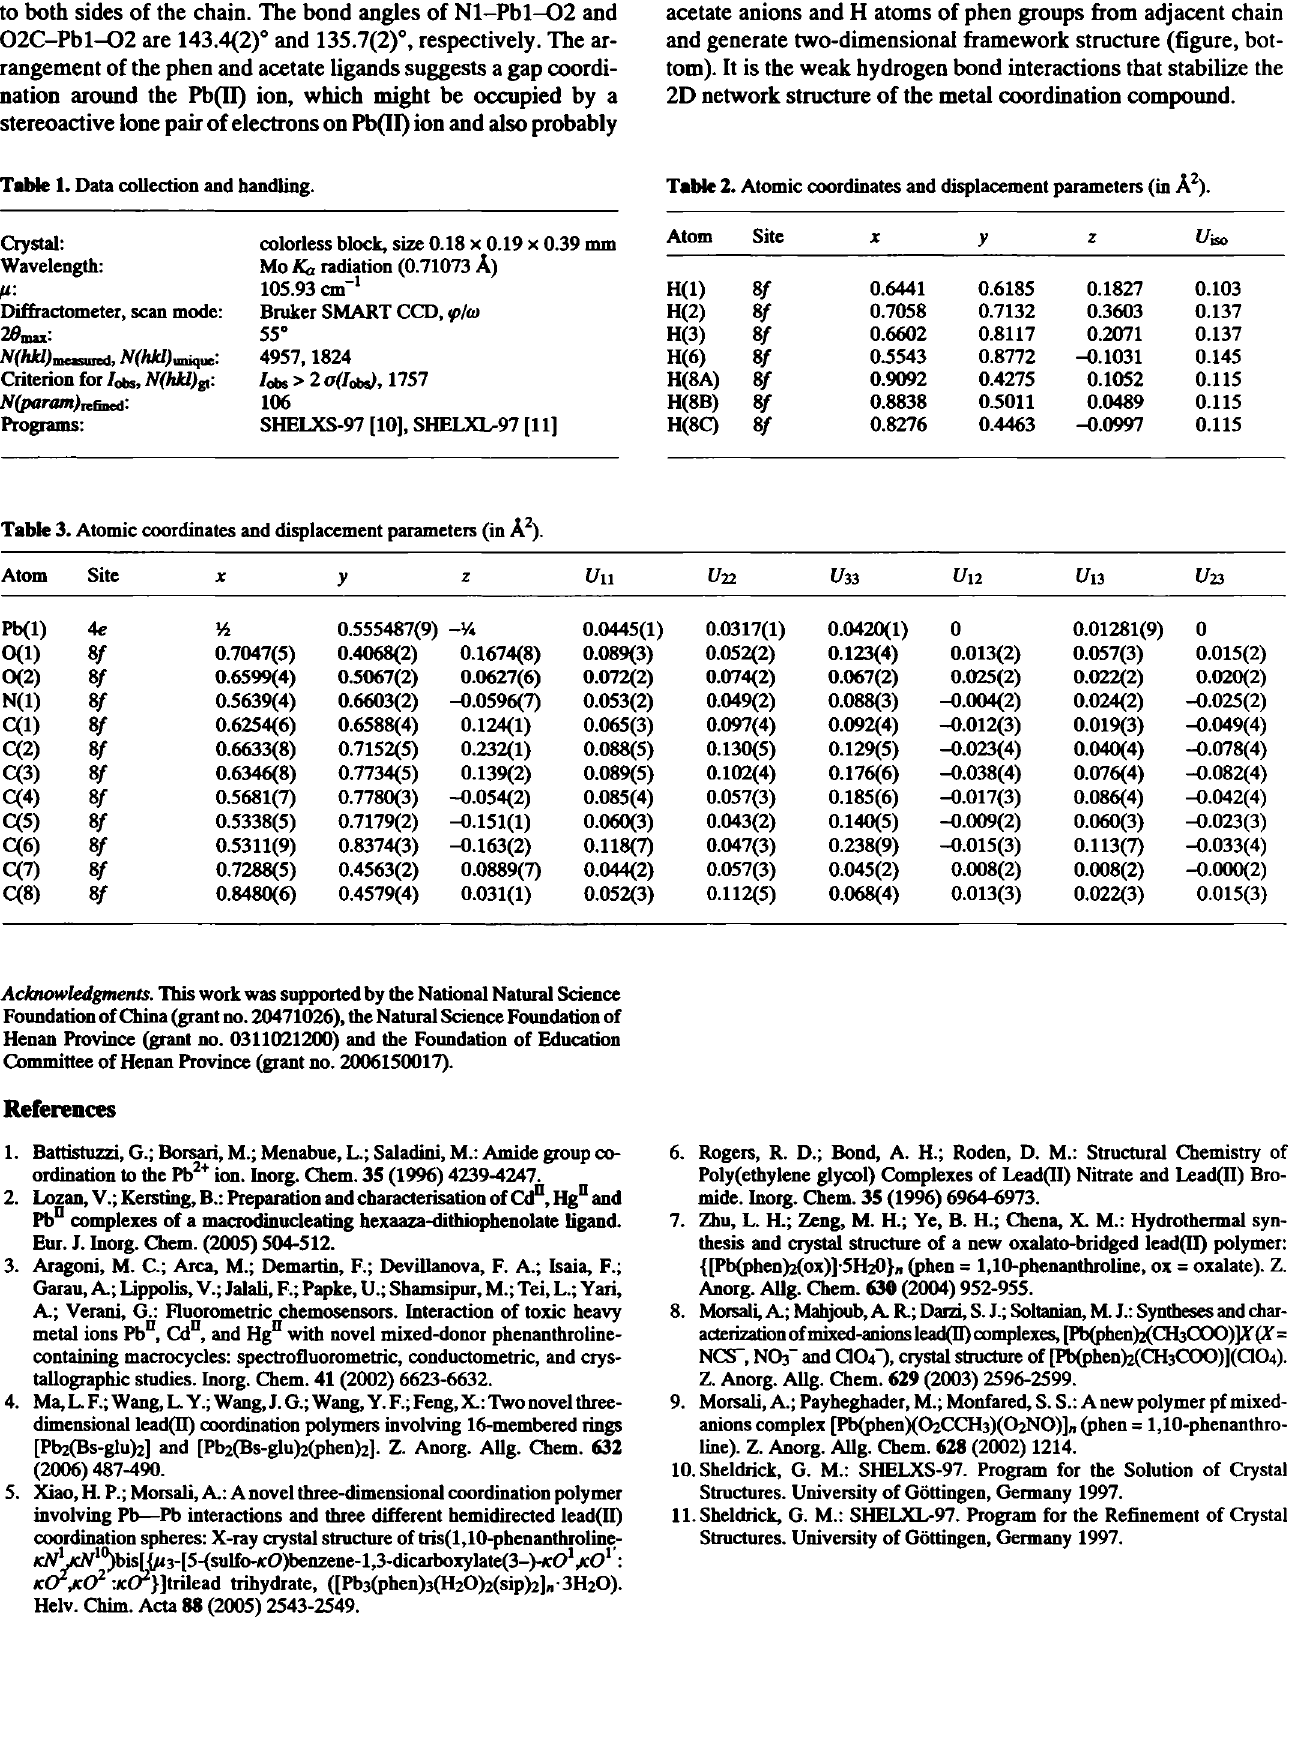
Table 3. Atomic coordinates and displacement parameters (in A 2